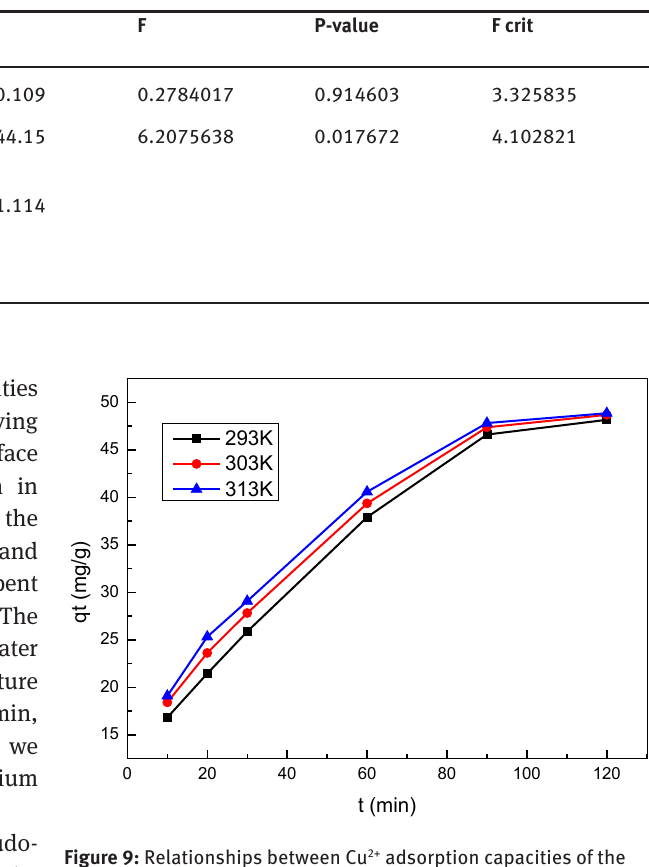
Figure 9: Relationships between Cu 2+ adsorption capacities of the fermented resides and time at different